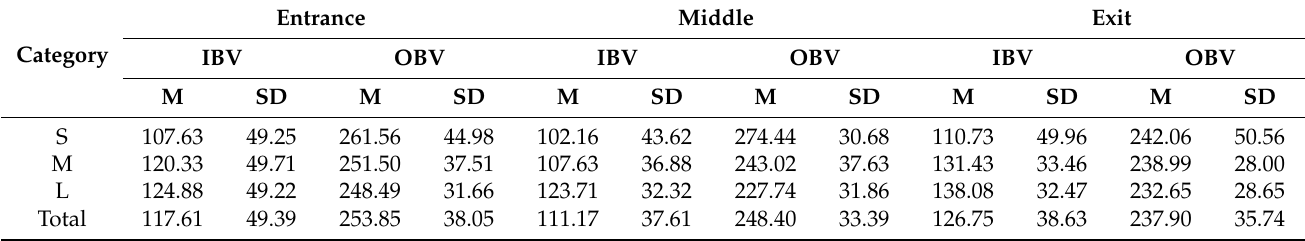
Table 2. Main statistics of the vessels that passed through the gate lines during the survey period (Unit: meter). Category